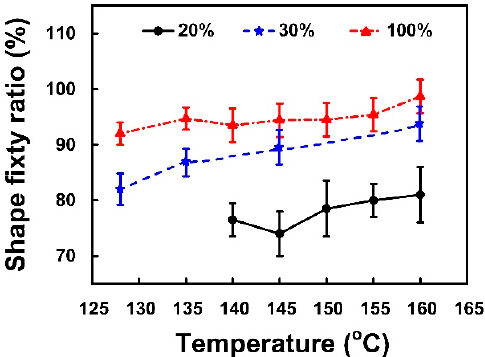
Figure 9. Shape fixity ratio ( R f ) against programming temperature with three different maximum programming strains.